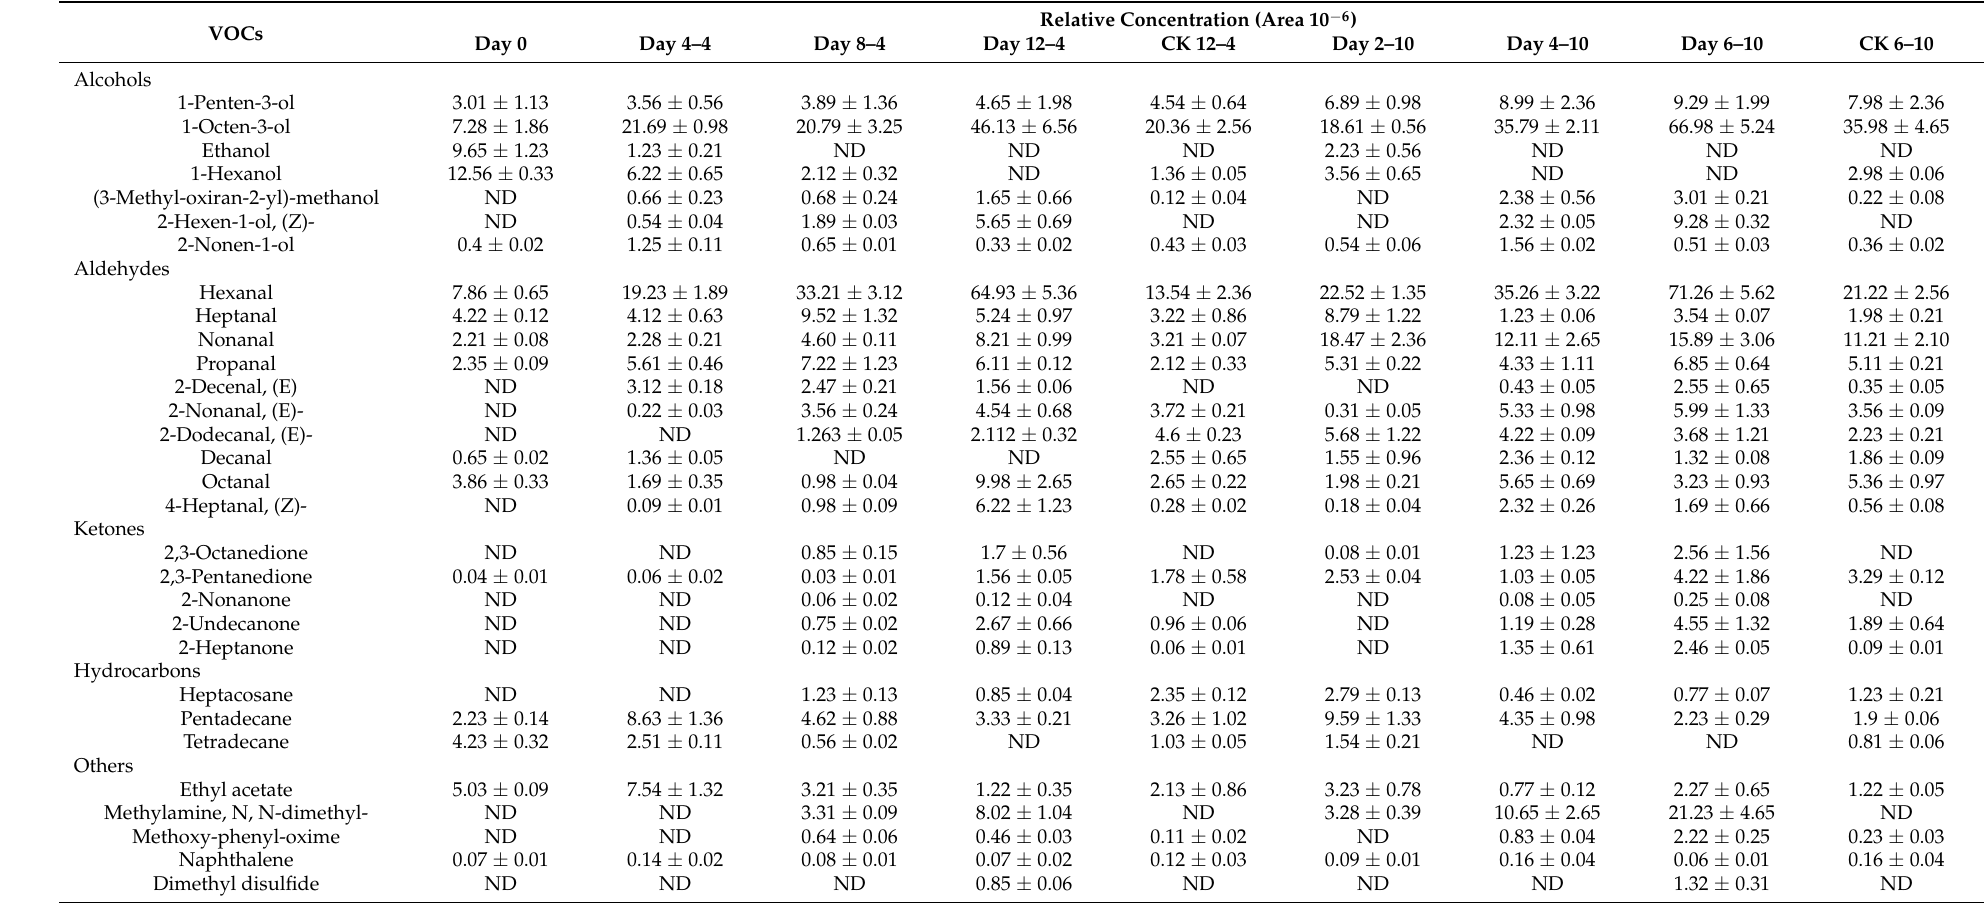
Table 4. Volatile organic compounds (VOCs) in tuna at 4 and 10 ◦ C. Day 4–4, day 8–4, and day 12–4: inoculated tuna stored for 4, 8, and 12 days at 4 ◦ C, respectively. Day 2–10, day 4–10, and day 6–10: inoculated tuna stored for 2, 4, and 6 days at 10 ◦ C, respectively. CK 12–4 and CK 6–10: non-inoculated tuna stored for 12 and 6 days at 4 and 10 ◦ C,